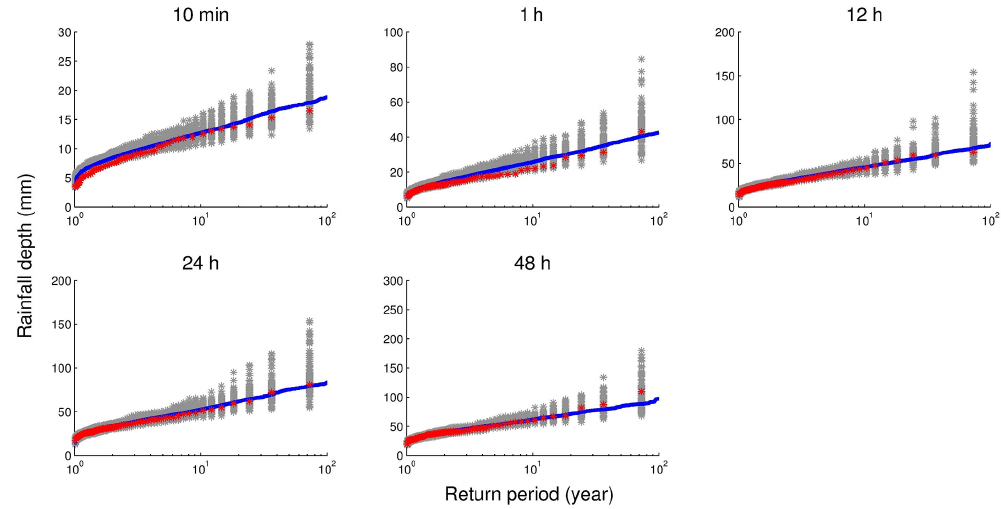
Figure 10. Comparisons between the return periods of extremes for the observed and simulated precipitation data at different aggregation levels: Uccle is in red and the ensemble of 50 simulated time series by the MBL model is in grey. Calculation of the extremes for a given return period on a time series that is based on concatenating the 50 simulated time series results in the blue line.